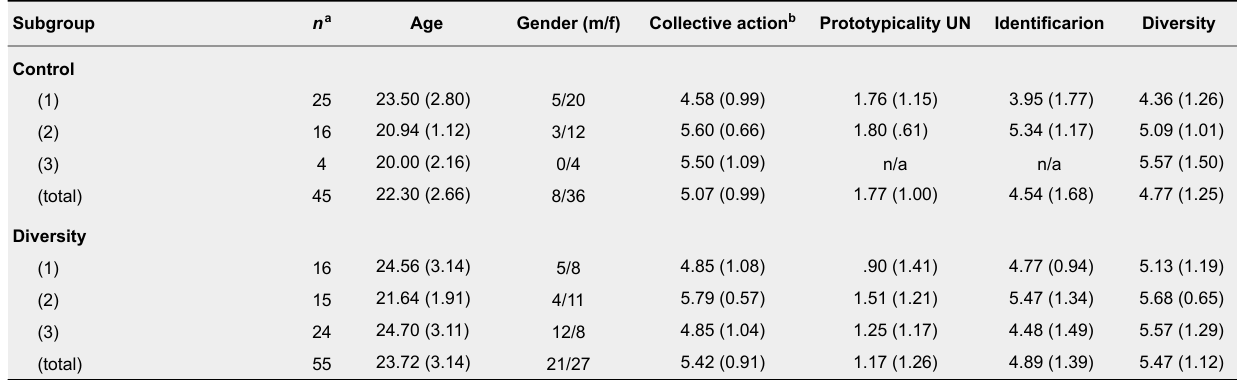
Summary of Main Results and Demographic Composition of Subgroups in the Two Conditions, all at Measurement Point